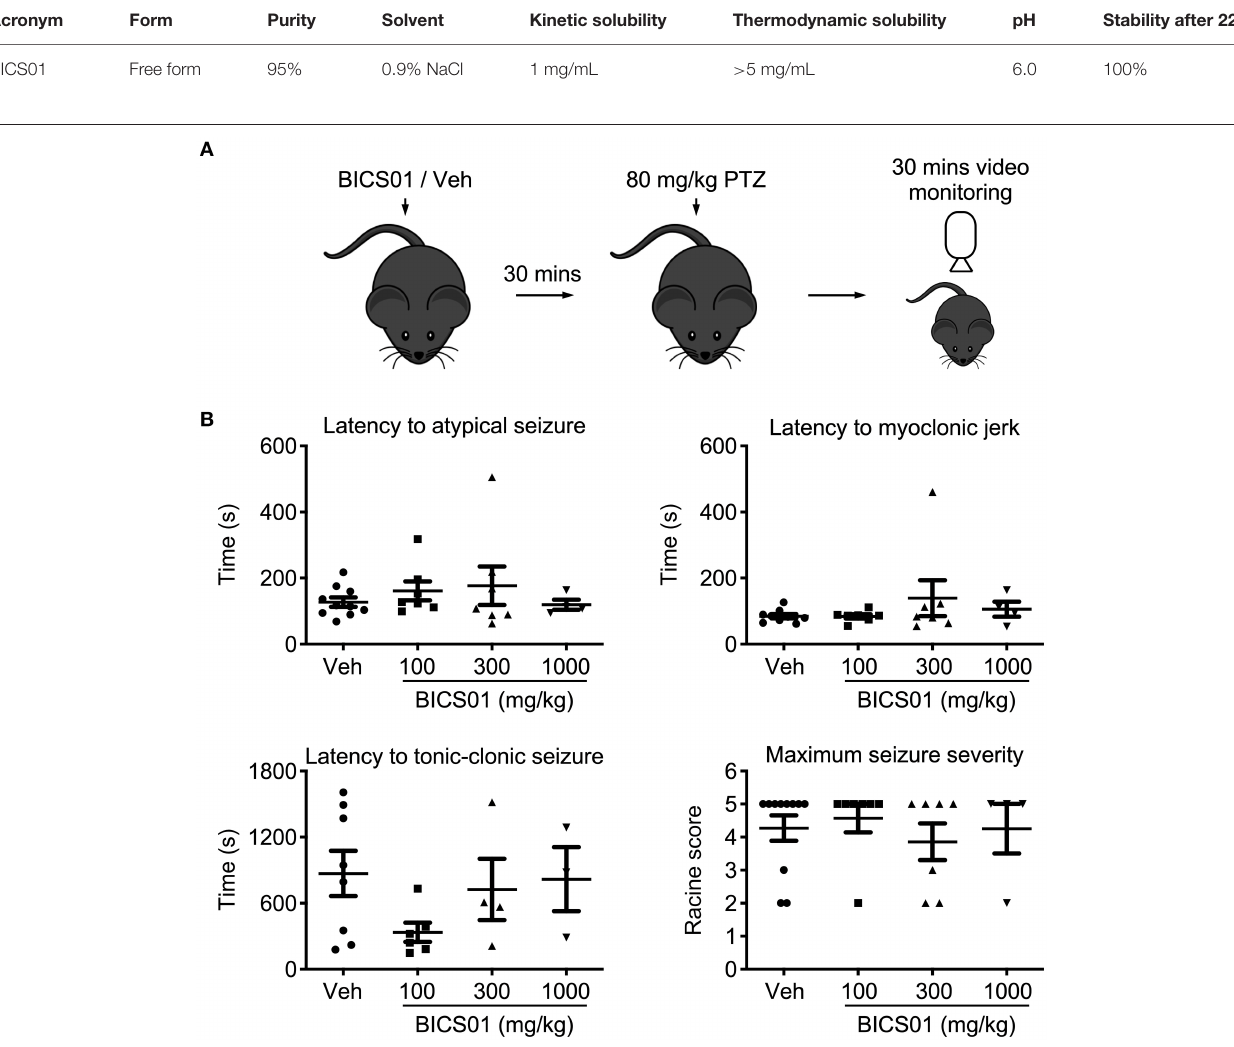
FIGURE 2 | Acute systemic application of BICS01 has limited effects in an acute in vivo seizure model. (A) Experimental overview. BICS01 (100, 300, or 1,000 mg/kg) or 0.9% NaCl vehicle were administered via IP injection 30min prior to acute seizure induction with pentylenetetrazol. Mice were video monitored for the following 30min to observe the behavioral manifestation of acute seizures. (B) Latencies to atypical seizure, myoclonic jerk and tonic-clonic seizure, as well as maximum seizure severity reached, were all unchanged.